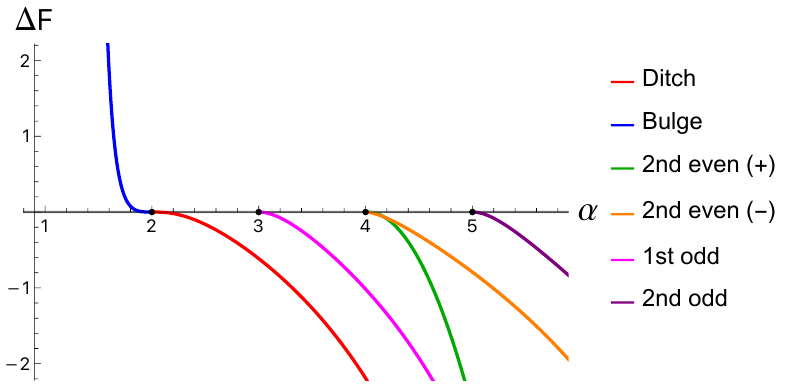
Figure 2 . Free energy of the deformed funnels compared with the uniform funnel. The dots denotes the onsets of instability on the uniform funnel. For the second even branches, ( ± ) denotes the signature of m (0)